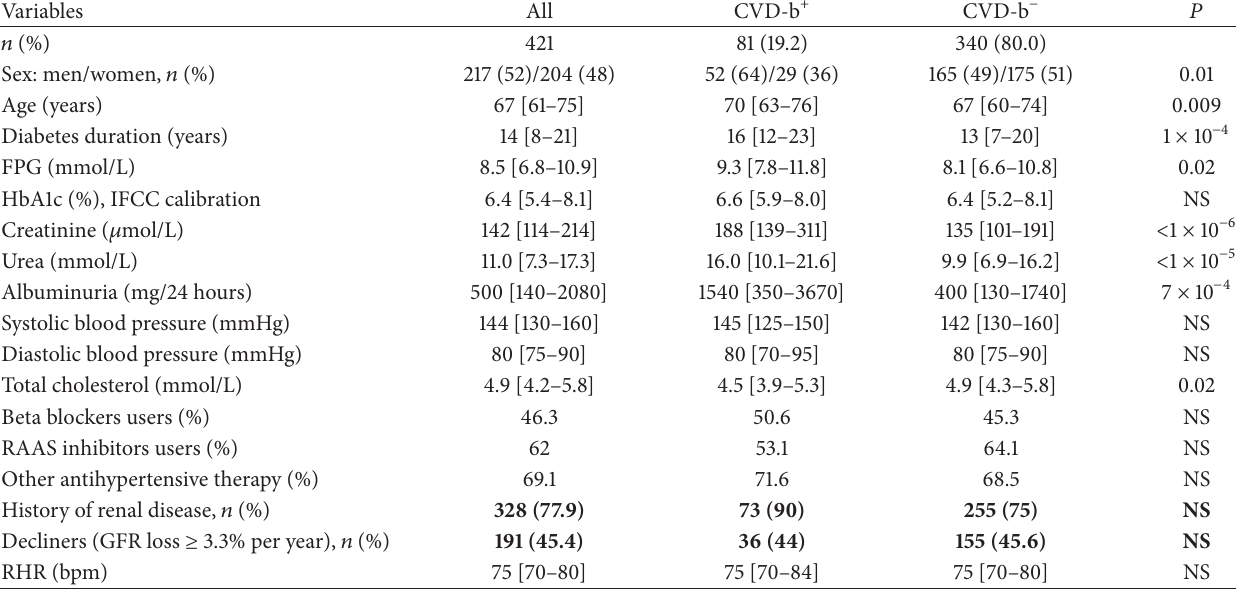
Table 1: Clinical and biochemical characteristics of subjects divided according to history of CVD, baseline